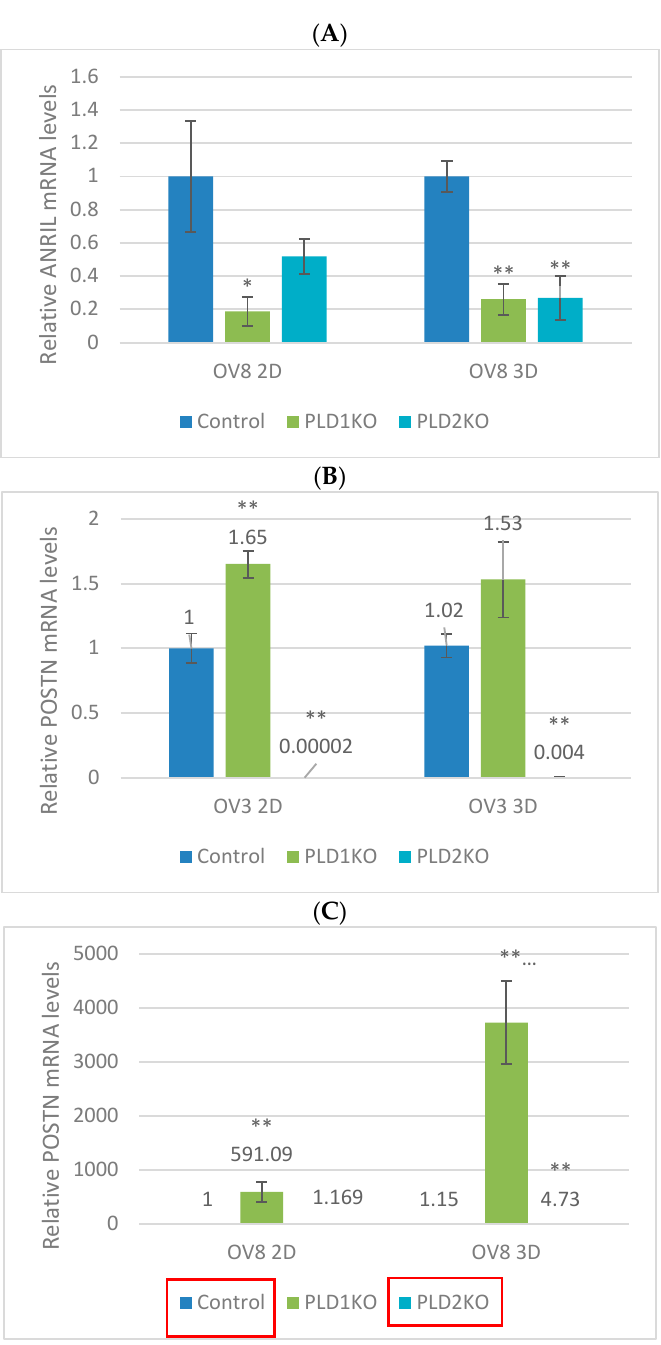
Figure 5. mRNA levels of ANRIL and POSTN. ( A ) ANRIL expression is reduced in PLD1-KO cells of OVCAR8 in both monolayer and spheroid form, whereas in PLD2-KO its reduced only in the spheroid form (* p < 0.05, ** p < 0.01). ( B ) POSTN mRNA levels are decreased in PLD2-KO of OVCAR3 in both forms ( p < 0.01). ( C ) POSTN mRNA levels are induced in PLD1-KO of OVCAR8 in both forms ( p < 0.01).